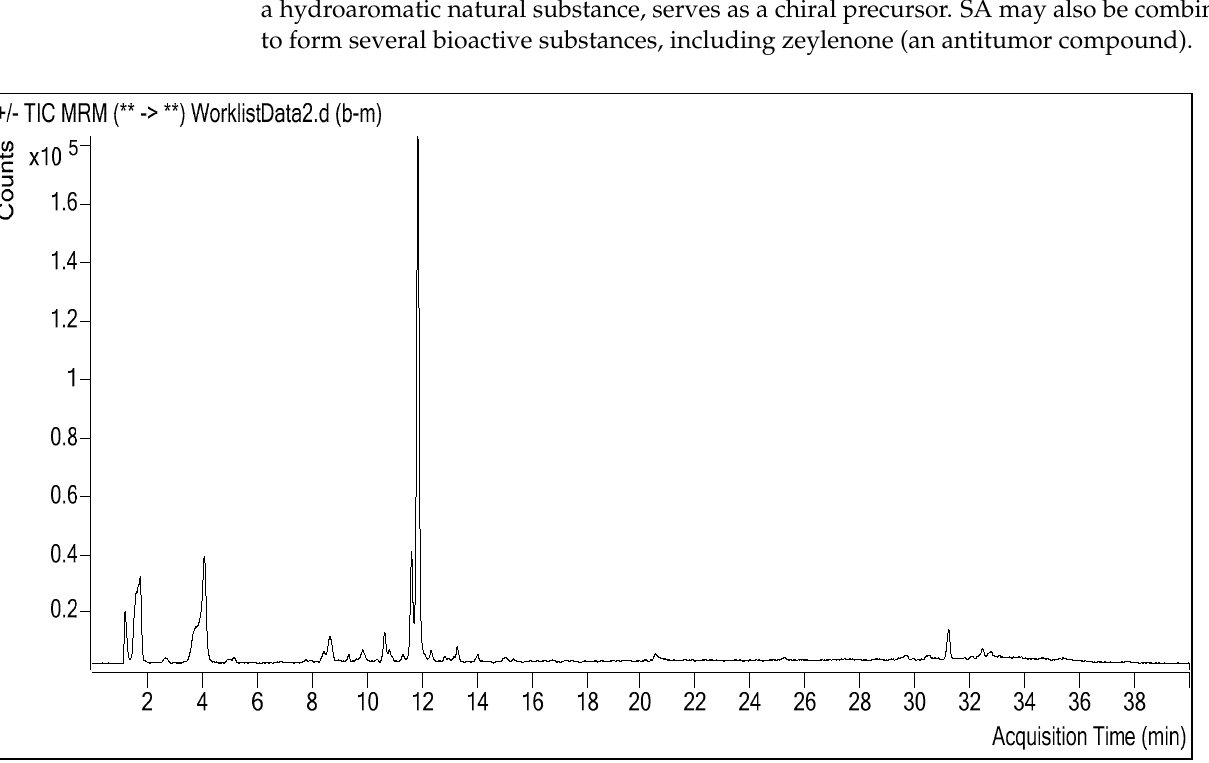
Figure 1. Sample chromatogram from LC-ESI-MS/MS analysis. Table 1. LC-MS/MS quantitation results of Amygdalus communis methanol extract.